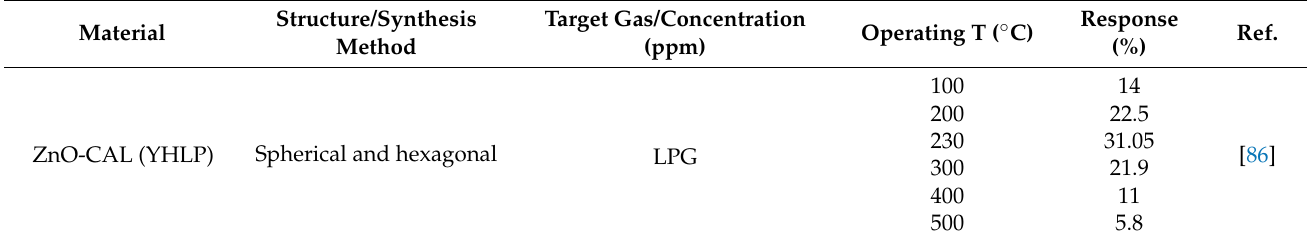
Figure 18. ( a ) Sensing response of chemical-ZnO and bio-ZnO devices towards various concentrations of LPG; ( b ) the effect of temperature on the sensitivity of the chemical- and bio-ZnO devices towards 1000 ppm of LPG. Reprinted from Ref. [166] with permission of Elsevier Ltd., 2016. A list of studies dealing with ZnO NPs has been summarized in Table 6. Table 6. A brief summary of green-synthesized zinc-oxide as gas